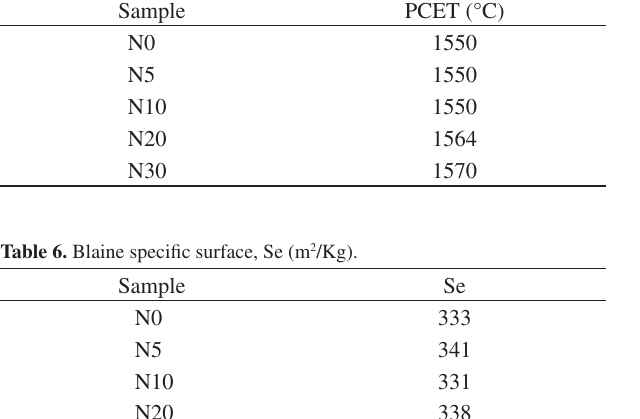
Table 5. Pyrometric Cone Equivalent Temperature (°C). Sample